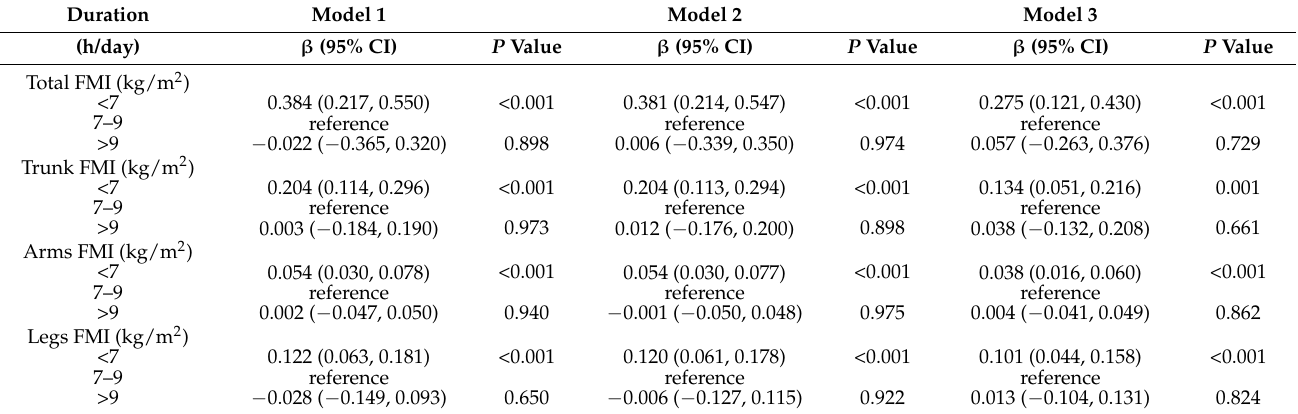
Table 2. Association between different regional fat mass and sleep duration groups in the whole